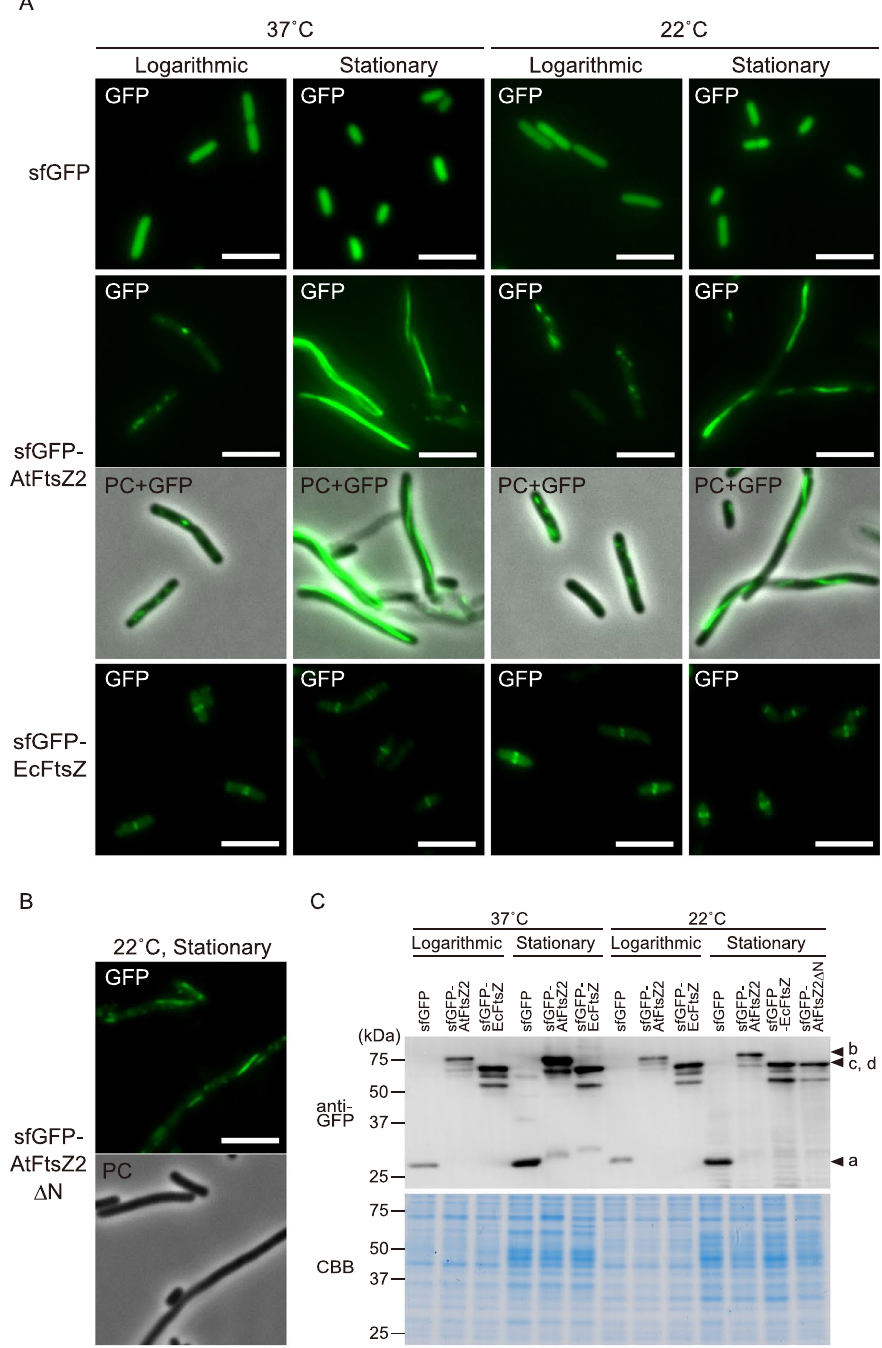
Figure 1. Chloroplast FtsZ2 assembles into filaments in Escherichia coli in a manner partially dependent on its N-terminus. ( A ) Fluorescence images of sfGFP-tagged FtsZ proteins from Arabidopsis thaliana (AtFtsZ2) and E. coli (EcFtsZ) expressed in E. coli wild-type strain WM1074 under various conditions. Scale bar: 5 μ m. ( B ) Filament morphology of sfGFP-AtFtsZ2 lacking the extra N-terminal region, in the stationary phase at 22 °C. Scale bar: 5 μ m. ( C ) Anti-GFP immunoblotting of each FtsZ protein under various conditions. Arrowheads indicate the full-length band of sfGFP (a), sfGFP-AtFtsZ2 (b), sfGFP-EcFtsZ (c) and sfGFP-AtFtsZ2 Δ N (d). Coomassie stain was used as a loading